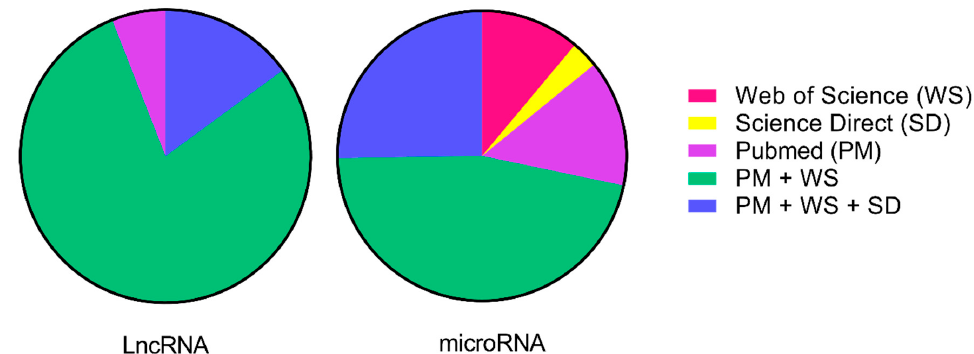
Figure 2. Percentage of articles found in one or more literature sources. A literature search was performed on PubMed (PM), Science Direct (SC), Medline (MD), and Web of Science (WS) databases using the following keywords: “long non-coding RNA/lncRNA” OR “microRNA/miRNA/miR” AND “tamoxifen resistance/tam-resistance/endocrine resistance”. We represented the final numbers of publications selected in this review. The Medline source had no studies after applying the exclusion criteria.